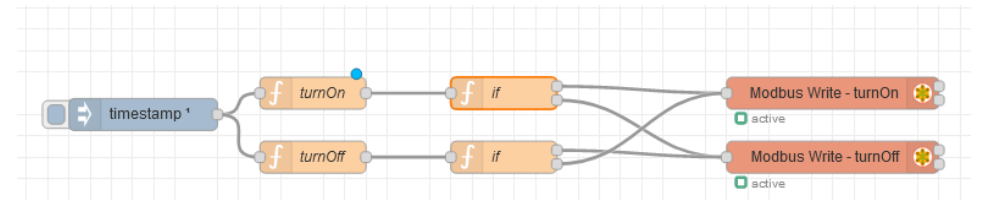
Figure 16. Flow in Node-RED ensuring the pause and start of conveyor